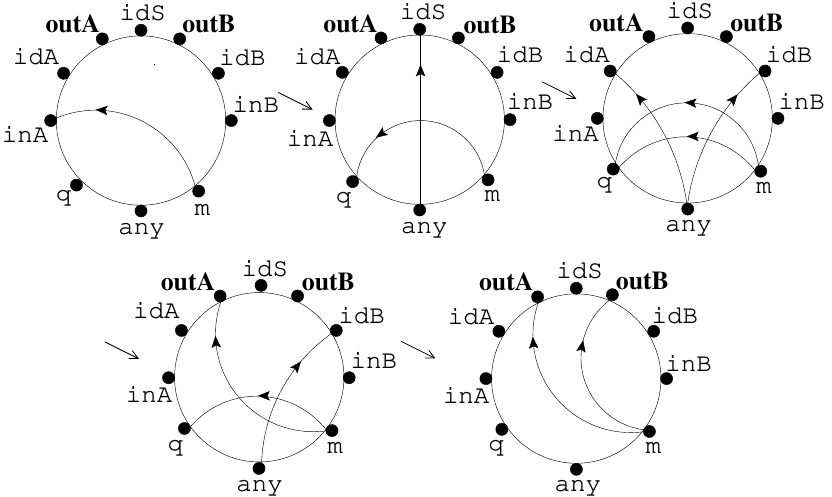
Figure 4. The evolution of the system (as it appears in the root